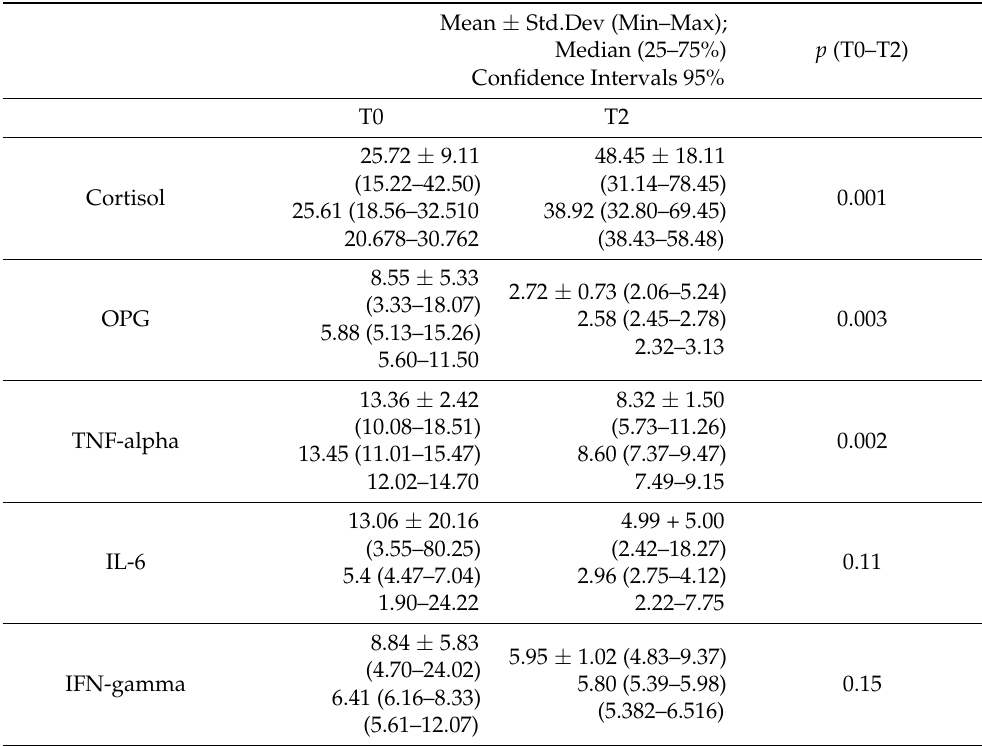
Table 3. Dynamics of salivary cytokine levels (mean ± std.dev (min–max), median (25–75%), and confidence intervals 95%) in patients treated with self-ligating brackets